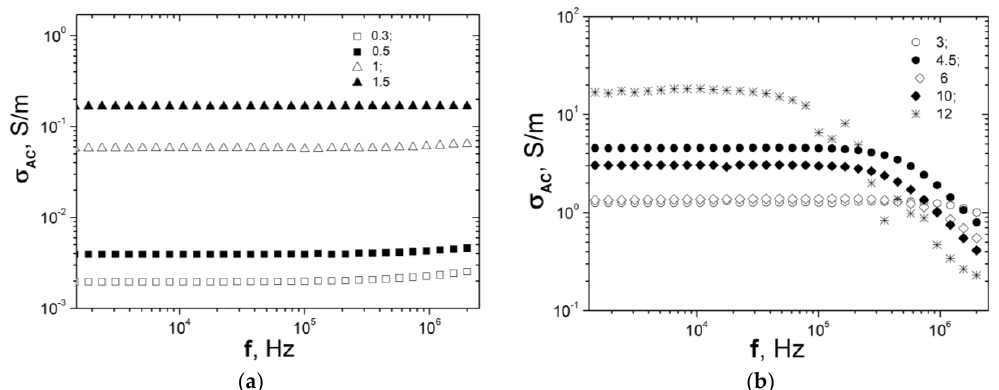
Figure 4. AC conductivity of PE-based composites filled with carbon nanotubes versus frequency. ( a )—CNT content is 0.3–1.5 vol%; ( b )—CNT content is 3–12 vol%.